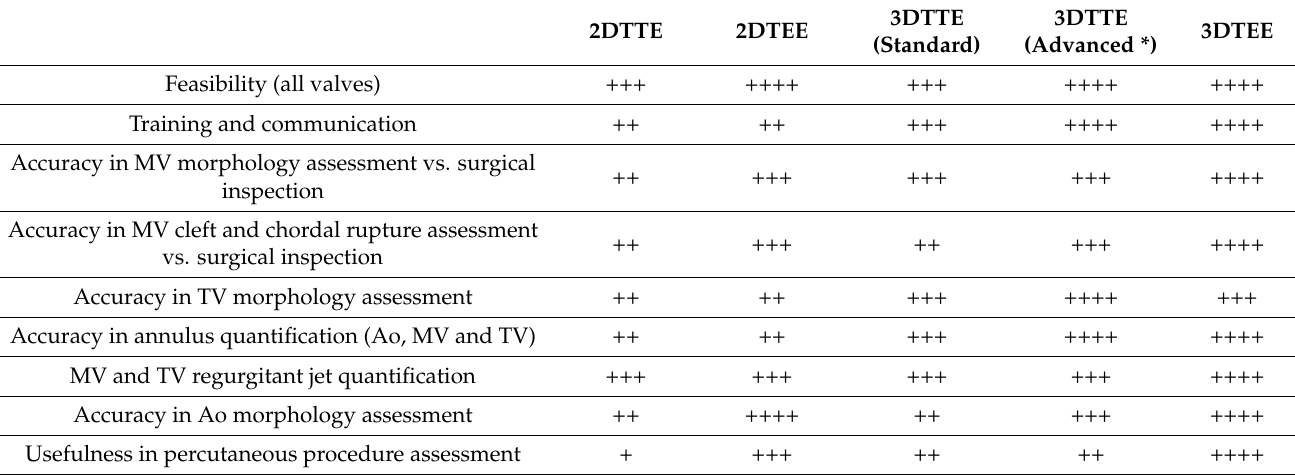
Table 1. Head to head comparison of 2D and 3D modalities in valve morphology